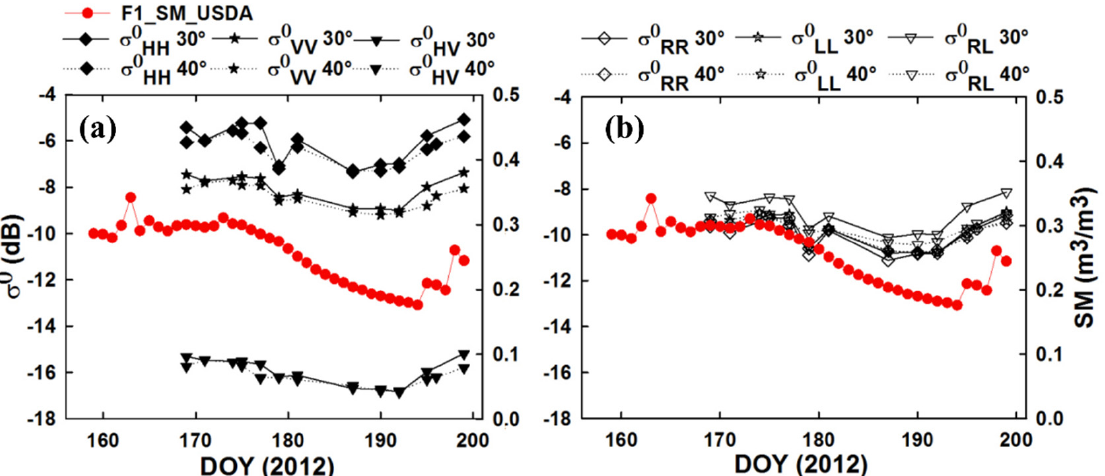
Figure 4. Temporal profiles of L-band ( a ) linear (HH, VV, and HV) and ( b ) circular (RR, LL, and RL) polarizations at θ = 30 and 40° along with soil moisture measurements over F1. F1_SM_USDA is the soil moisture measured by the USDA station.